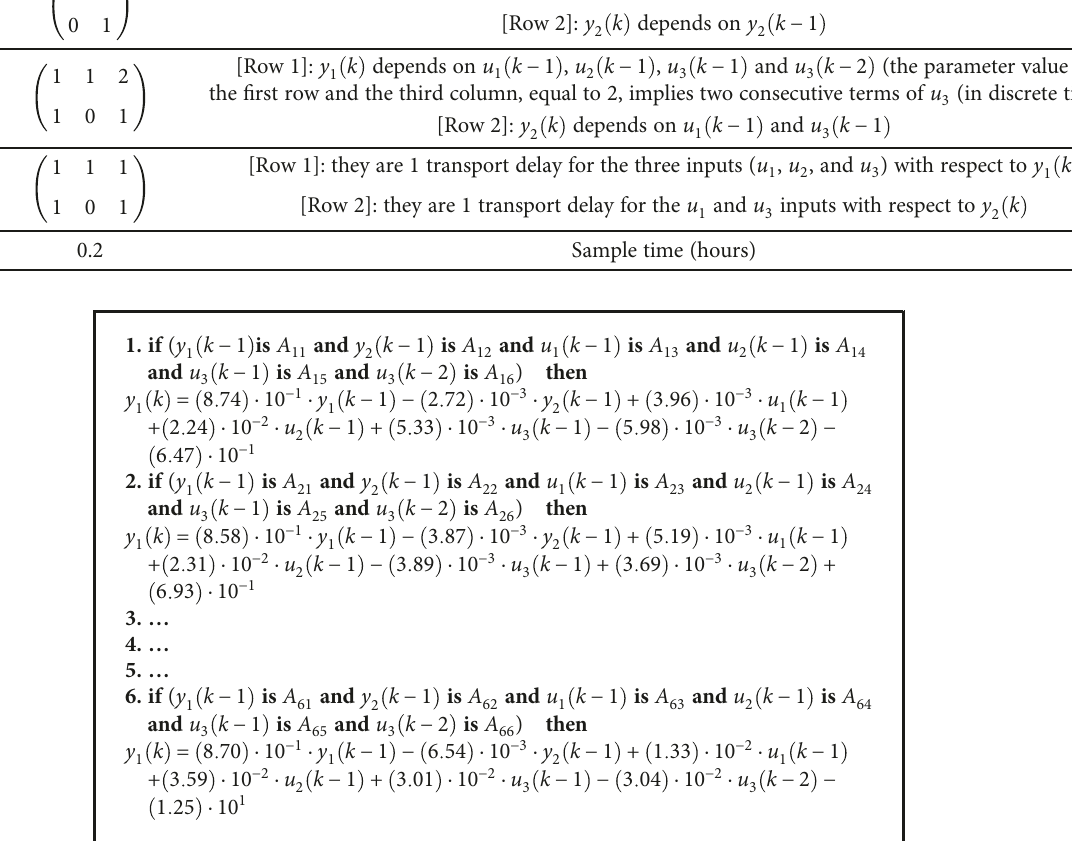
Algorithm 2: Takagi-Sugeno fuzzy model for substrate y